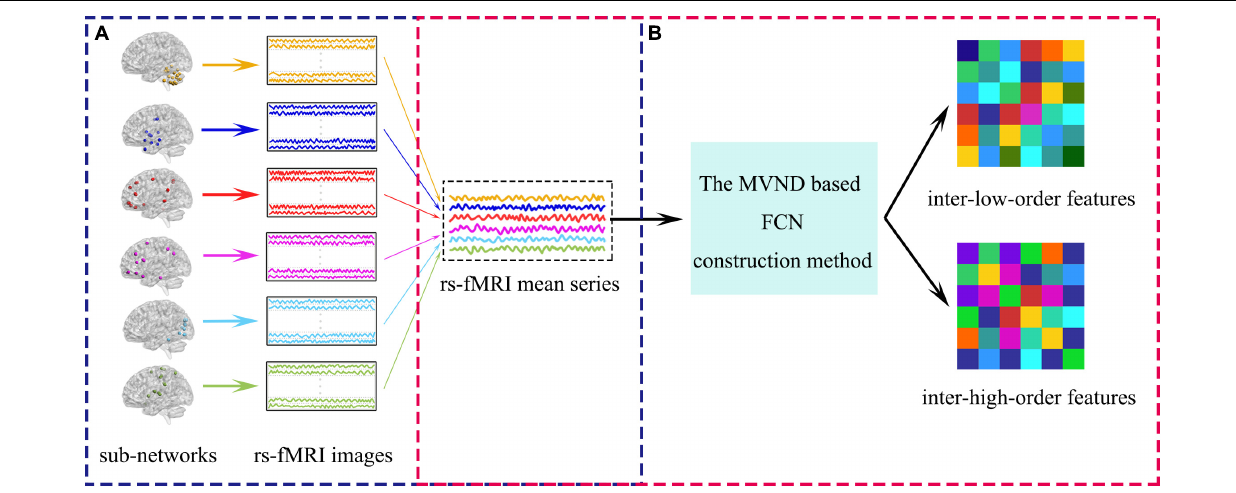
Frontiers in Neuroscience |